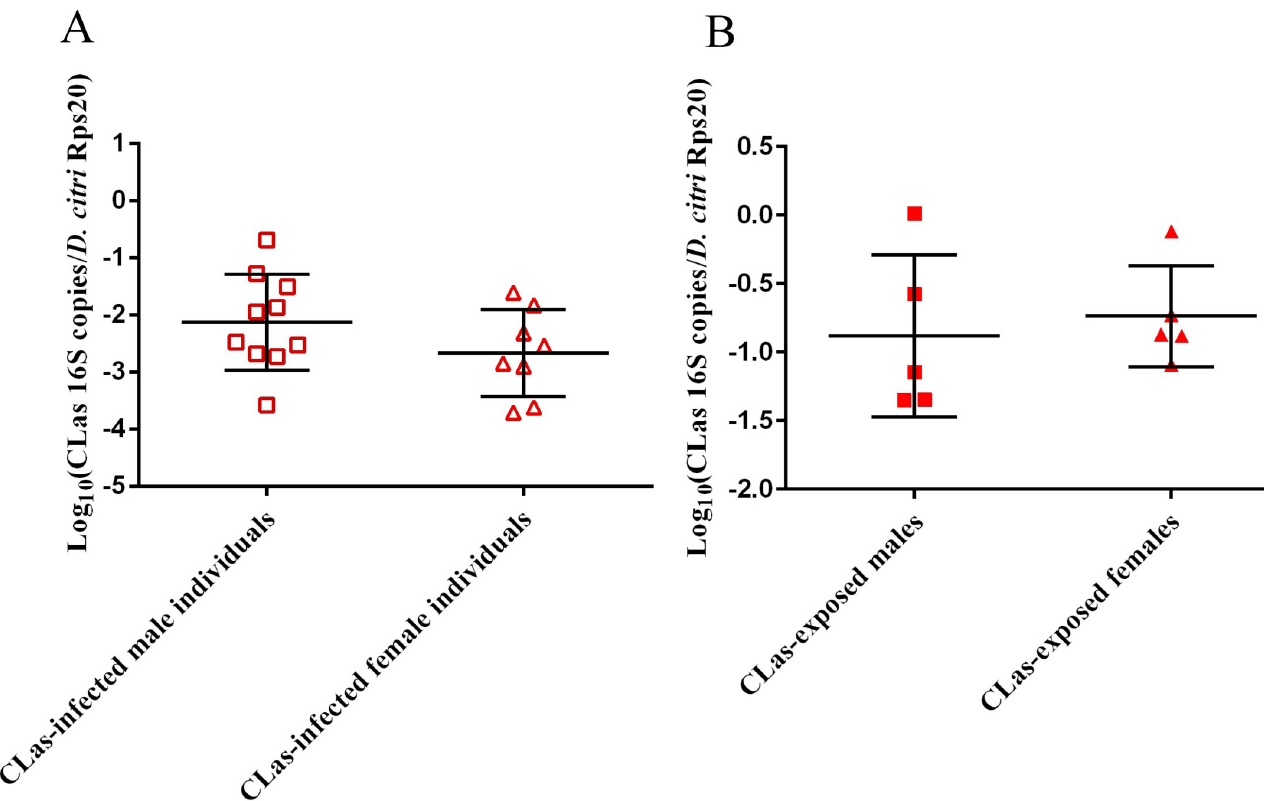
Fig 1. CLas density in FL D . citri reared on FL CLas-infected C . medica . (A) The density of CLas in individual and (B) 75-individual pooled D . citri samples was determined using qPCR. A significant difference between mean densities of CLas in CLas-infected male and female individuals or between 75-individual pooled, CLas-exposed male and female D . citri was determined using a two-tailed, unpaired t-test.